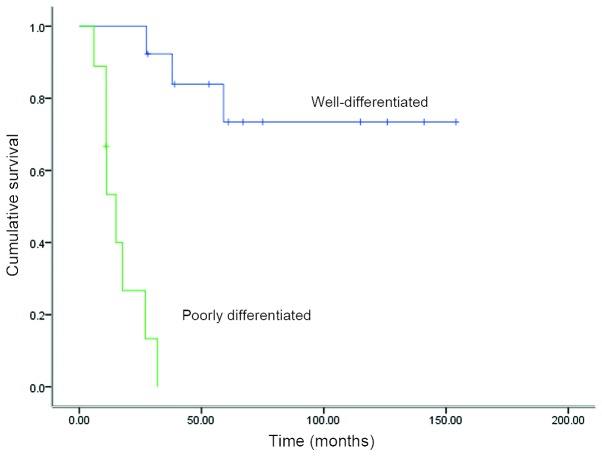
Kaplan-Meier curves comparing the survival times of patients with well- and poorly differentiated neuroendocrine carcinomas (P<0.001).